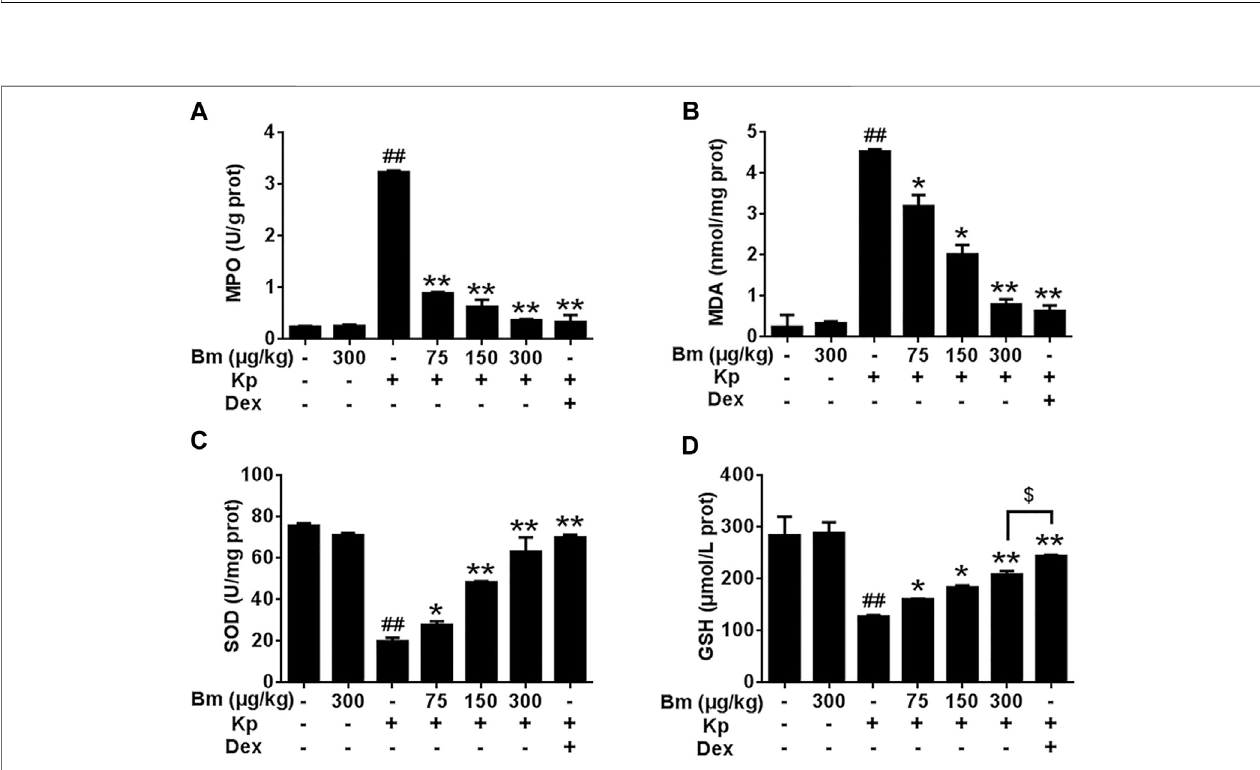
FIGURE5| Effects of Bergeninmonohydrate onMPO (A) ,MDA (B) ,GSH (C) andSOD (D) levelsinlungtissues after Klebsiellapneumonia infection. * p < 0.05and ** p < 0.01 indicate signi fi cant differences compared with the Klebsiella pneumonia only group. All data are presented as the means ± SEM ( n (cid:2) 5 in each group). ## p < 0.01 vs the Control group; * p < 0.05 and ** p < 0.01 vs the Klebsiella pneumonia group; $ p < 0.05 vs the Dex